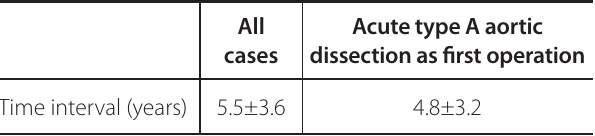
Table 4 . Time interval between the first surgery and